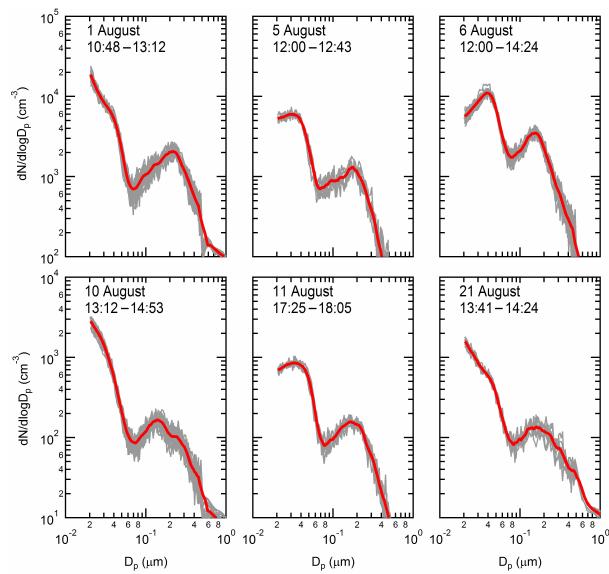
Figure 5. SMPS and APS derived size distributions used for each case study in Table 2. The 5 August size distribution is used for both the coupled and decoupled case. Individual distributions (grey) are from the indicated time ranges in the figure. The time ranges are in UTC. Average distributions are shown in red.